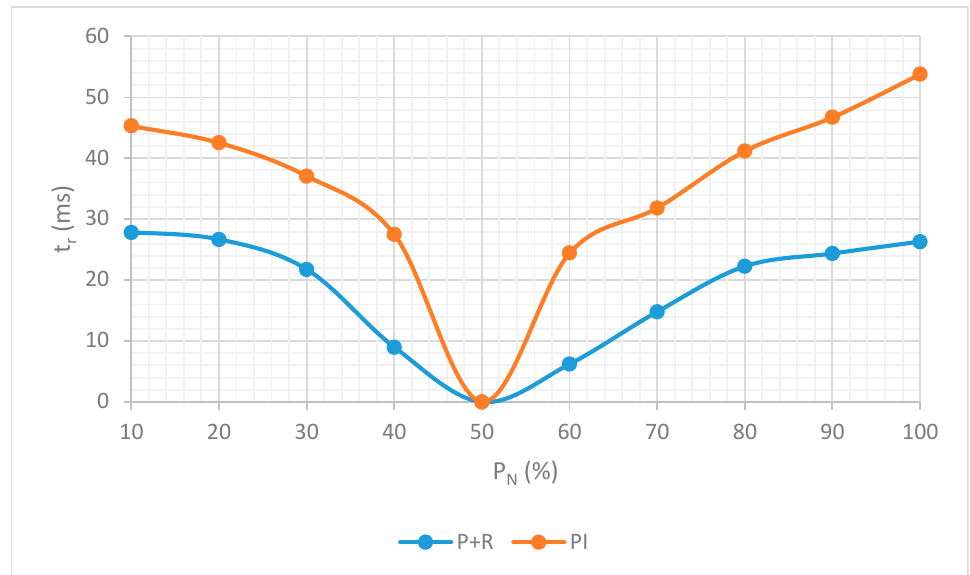
Figure 20. Comparison of adjustment times of P+R and PI controllers in the tested system for changes in the set active component (from 0.5 P N to the set one).